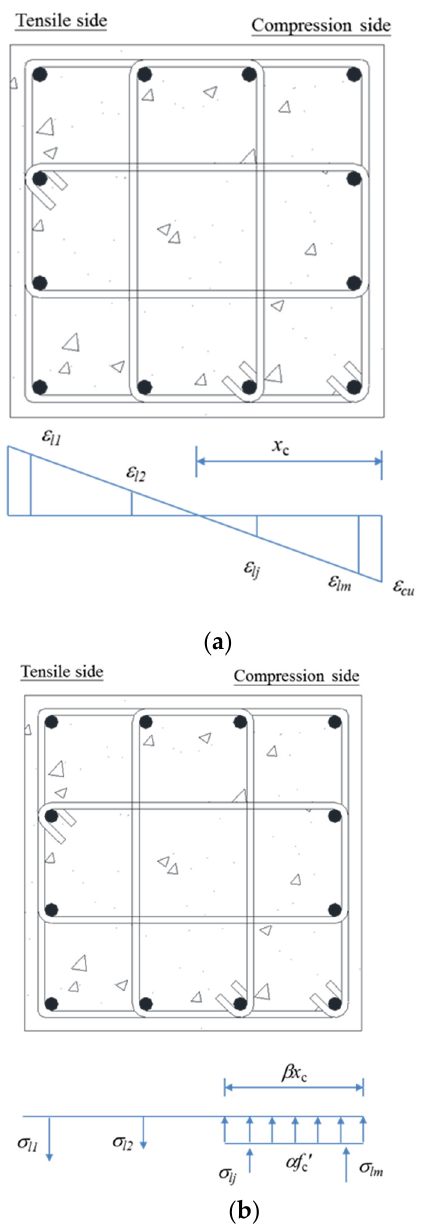
where n f is the fastener number in a connection; A c is the cross-sectional area of the col- umn; and d w is the depth of the column.